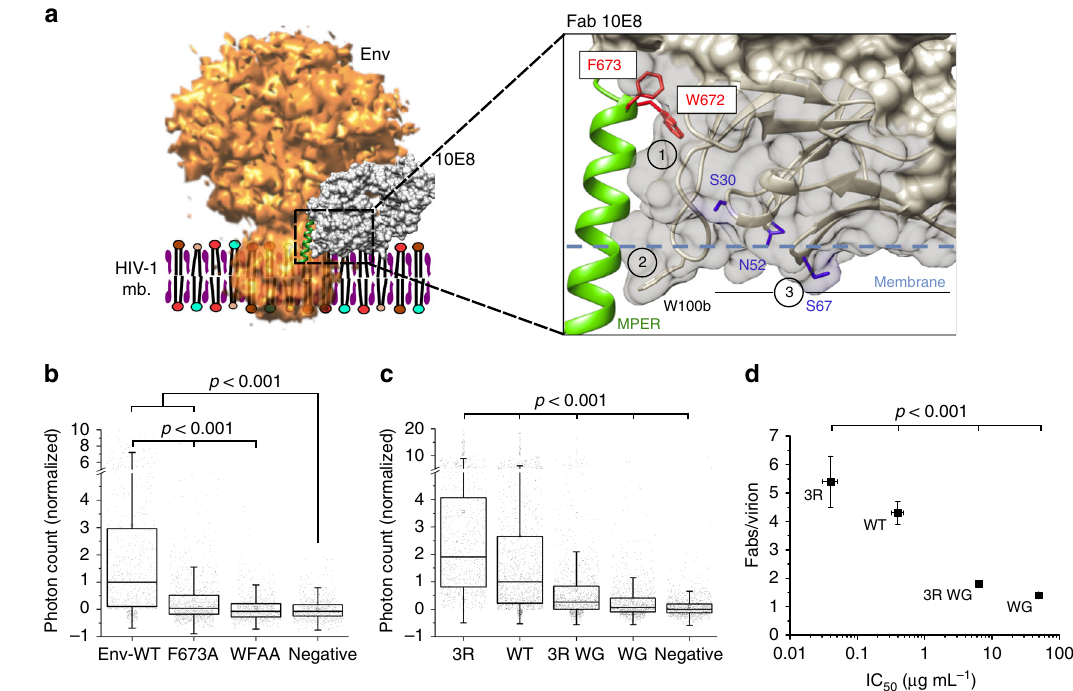
Fig. 5 Dependence of 10E8 binding to native MPER on the functional paratope elements. a Structural model to designate: (1) speci fi city pocket, (2) HCDR3, and (3) MAPA regions on 10E8 (EMD entry code 3308 15 and PDB 5GHW 10 ). Side chains of residues Trp 672 and Phe 673 critical for epitope peptide binding and neutralization are displayed in red onto the bound MPER helix (green ribbon). Fab residues from the HCDR3/MAPA region modulating membrane interaction and neutralization activity, Trp 100bHC , and residues mutated to Arg (in blue: Ser 30 LC , Asn 52 LC , Ser 67 LC ) are displayed in stick representation. b STED intensity signals of the antibodies (after background subtraction and normalization) in HIV-1 virions pseudotyped with JR-CSF Env-WT ( n = 939) and Env versions with single F673A ( n = 1270) or double W672A/F673A (WFAA) ( n = 884) mutations in the MPER. c Binding to Env on intact virions of anti-MPER bnAbs mutated in the MAPA/HCDR3 region. The intensity signals for each antibody was normalized to the WT signal after background subtraction (3R n = 1049, WT n = 1664, 3R WG n = 1437, WG n = 1444). d Correlation between potency (IC 50 values for neutralization, determined